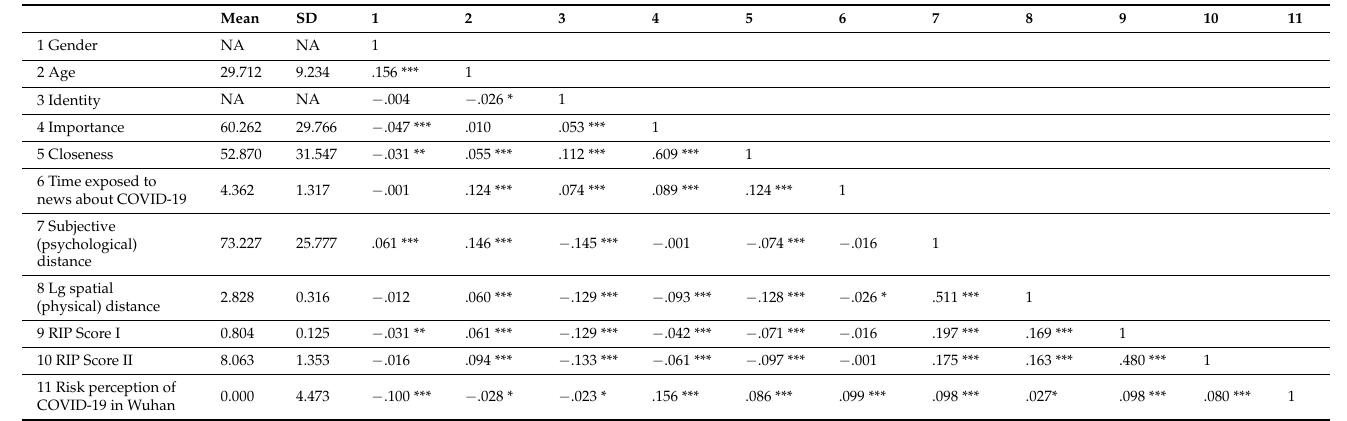
Table 3. Means, SDs, and pairwise correlations of the measures ( N = 7284, adult data with no missing values).